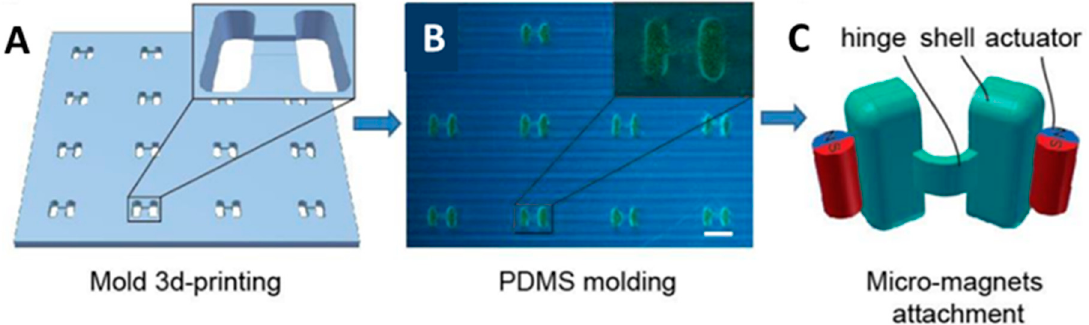
Figure 5. ( A ) Fabrication of a microrobot mold via three-dimensional (3D) printing. ( B ) Image of the fabrication of PDMS (polydimethylsiloxane) shells in the mold. ( C ) Schematic illustration of scallop swimmers. Adapted with permission from Reference [108], copyright Nature Communications 2014.